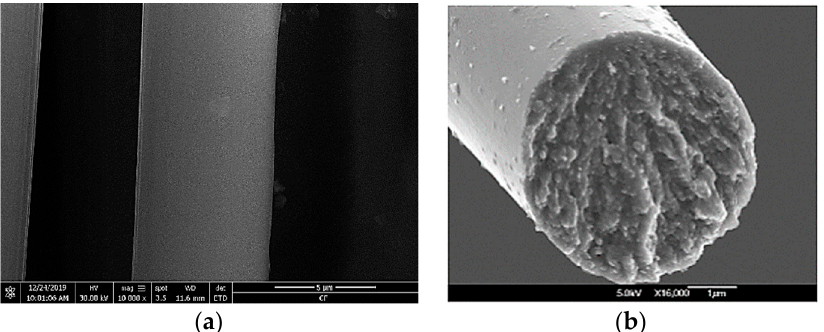
Figure 1. SEM micrographs of ( a ) our single fiber and ( b ) fiber tensile fracture surface at surface cross section from [24].